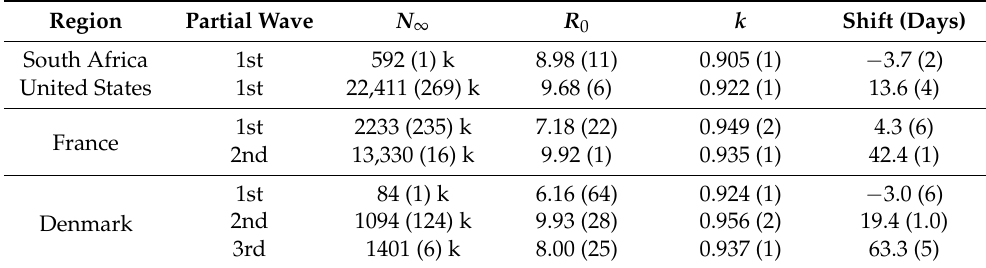
Table 5. The parameters of the Gompertz curves for other countries from November 2021 to Febru- ary 2022. The definition of the parameters is the same as in Table 3, but the reference dates are 24 November 2021, 30 November 2021, 1 November 2021 and 1 November 2021 for South Africa, United States, France and Denmark, respectively.